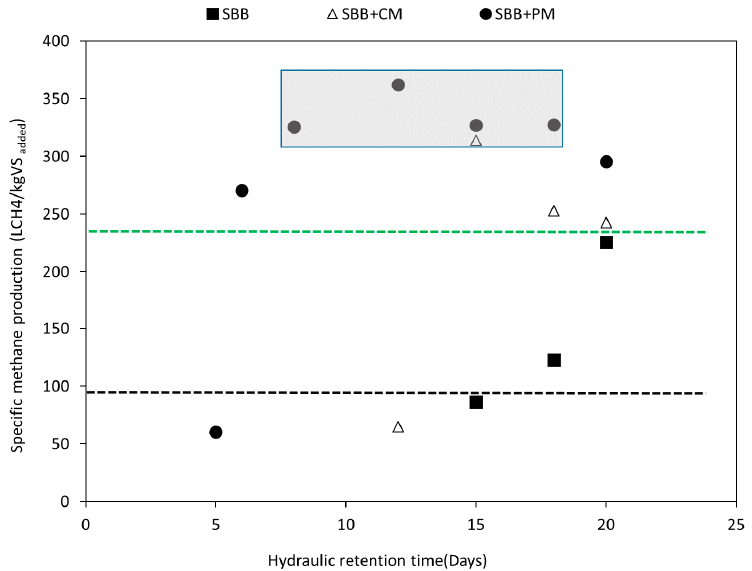
Figure 3. Specific methane productions at the different hydraulic retention time in the three SSTR digesters. Greenline: the specific methane production (SMP) value of 73% of the average SMP obtained. Blackline: the value of 27% of the average SMP obtained. Blue box: the highest SMP values in anaerobic digesters.